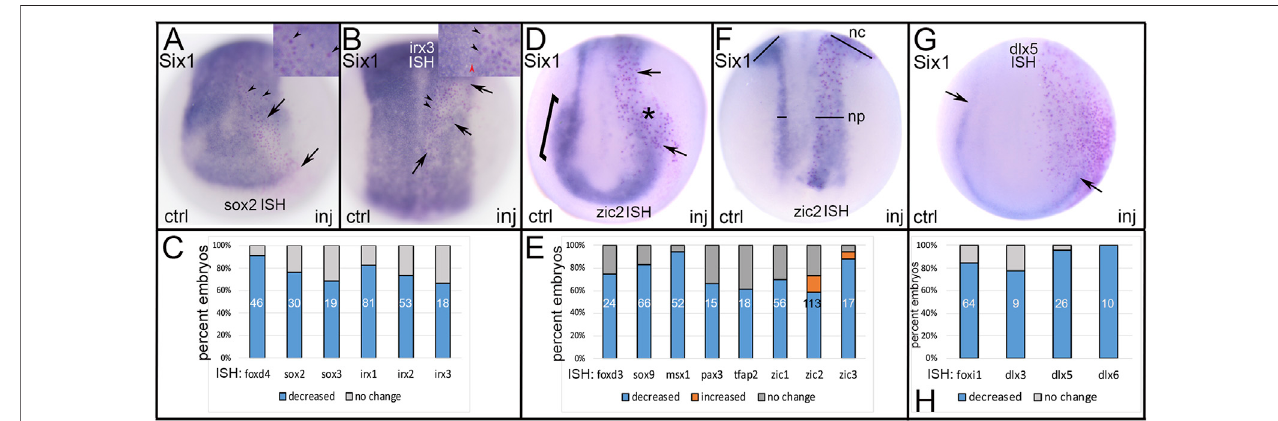
FIGURE 4 | The effects of expressing a PPR-enriched transcription factor, Six1, in ectopic domains. (A) Ectopic expression of Six1 (PPR TF) in a neural plate precursor blastomere (red dots between arrows) showed reduced expression of sox2 (NP TF). Arrowheads in low magni fi cation image and inset indicate Six1- expressing cells containing a red lineage-tagged nucleus surrounded by clear cytoplasm denoting reduced sox2 expression. In this case, the effect was cell autonomous. ctrl, control side; inj, injected side, anterior viewwith dorsal to the top. (B) Ectopic expression ofSix1 (PPR TF) in aneural plate precursor blastomere (red dots betweenarrows) showed reduced expression of irx3 (NPTF). Black arrowheadsin lowmagni fi cation image and inset indicate Six1-expressing cells containing a red lineage-tagged nucleus surrounded by clear cytoplasm denoting reduced irx3 expression. In this case, the effect was cell autonomous. Red arrowhead in inset indicates a cell thatdoes not ectopically express Six1 (clearnucleus) and expresses normal levels of irx3 (dark blue), forcomparison. Dorsal view with anterior to thetop. (C) The percentage of embryos in which the expression of several NP-enriched genes were reduced by ectopic expression of Six1. Numbers within the bars denote sample size. (D) Ectopic expression of Six1 (PPR TF) in a neural crest precursor blastomere (red dots between arrows) showed reduced expression of zic2 in both the neural plate (arrows) and neural crest (*) domains. The NC domain of zic2 on the control side is indicated by a bracket. Anterior view with dorsal to the top. (E) The percentage of embryos in which the expression of several NC-enriched genes was reduced (blue) or expanded (orange) by ectopic expression of Six1. Numbers within the bars denote sample size. (F) In a small number of embryos, ectopically expressed Six1 (PPR TF) expanded the neural plate (np) and neural crest (nc) expression domains of zic2. Bars compare the widths between control (ctrl) and injected (inj) sides. Dorsal view with anterior to the top. (G) Ectopic expression of Six1 (PPR TF) in a lateral precursor blastomere (red dots) reduced expression of dlx5 (Epi TF) in the epidermis along the border zone. Arrows indicate the posterior limit of the dlx5 domain on control (ctrl) and injected (inj) sides. Anterior view with dorsal to the top. (H) The percentage of embryos in which the expression of several Epi-enriched genes was reduced by ectopic expression of Six1. Numbers within the bars denote sample